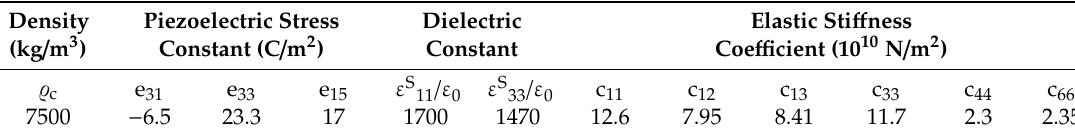
Figure 2. Finite element model of a 1 / 4 unit of the novel composite. Table 1. Parameters of PZT-5H.